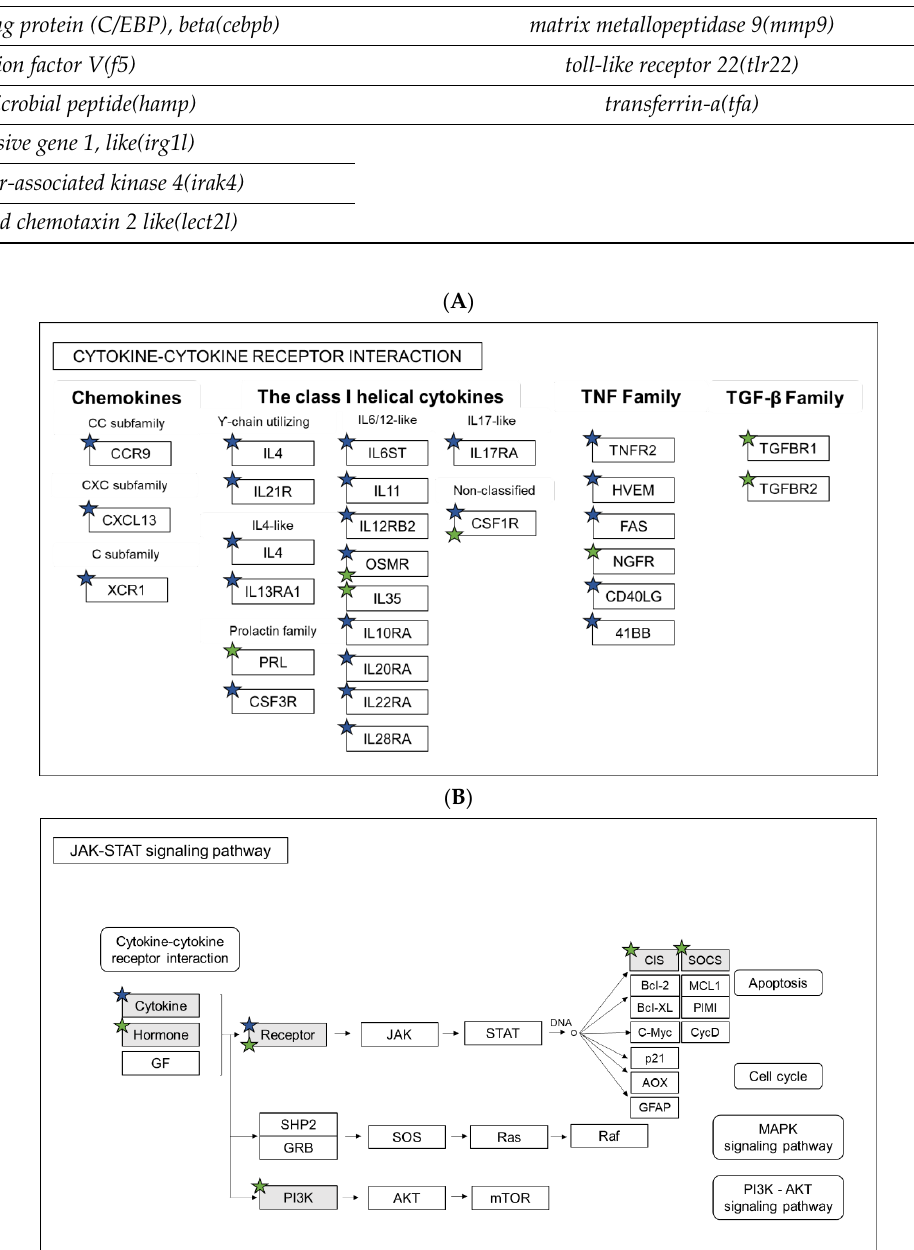
Figure 5. Pathway analysis. Comparison of regulated genes between gal+/+ and gal−/− larvae after M. marinum infection in KEGG Pathways: ( A ) Cytokine-cytokine receptor interaction and ( B ) JAK-STAT signaling pathway . Blue stars indicate genes regulated in gal+/+, while green in gal−/−. Table 1. Comparisons of affected pathways and biological processes in gal+/+ wild-type and gal−/− mutant larvae after M. marinum infection. Common processes are marked as grey.